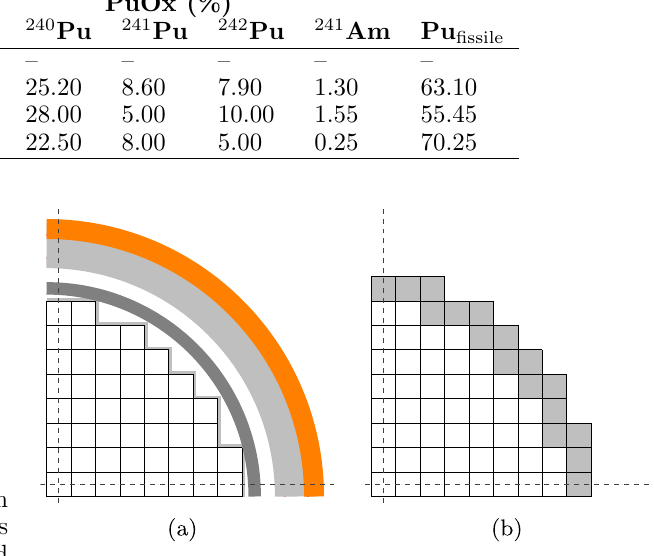
Fig. 4. Real (a) and simulated (b) PWR quarter core layout. Assemblies are displayed in white, whereas baffle (light gray), barrel (dark gray), vessel (gray) and thermal insulator (orange) are replaced by reflector elements